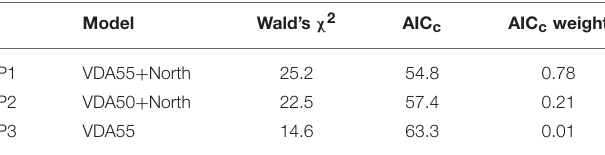
TABLE 5 | The three top regression models for incidence of crown death in Texas